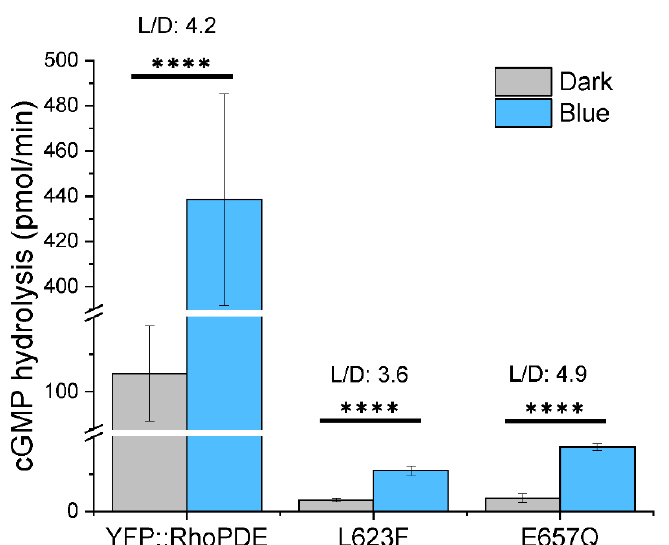
Figure 6. Sr RhoPDE L623F and E657Q mutants showed dramatically decreased cGMP hydrolysis activity with similar L/D ratios to wt. In vitro reactions were performed with 10 µ M cGMP in the dark and 473 nm blue light illumination at 0.1 mW/mm 2 . Activities of three constructs were adjusted to the same protein amount. n = 4, error bars = SD. The two-tailed t-test was used in statistical analyses. **** p < 0.0001. The broken Y ‐ axis symbol // was introduced from 20 to 90 and from 120 to 390, respectively.